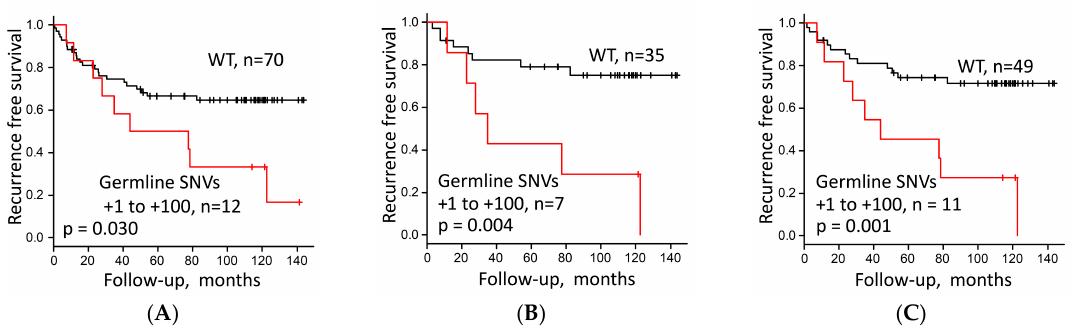
Figure 6. Recurrence-free survival stratified by ( A ) presence or absence of germline single-nucleotide variants (SNVs) at any site at positions +1 to +100 in the rDNA promoter region (presence versus wild type (WT)) in 82 lung adenocarcinoma (LUAC) patients, and ( B ) germline SNV at positions +1 to +100 in the rDNA promoter region (presence versus WT) in Stage I LUAC excluding MIA (n = 42), and ( C ) in Stage I/II LUAC excluding MIA ( n = 60).